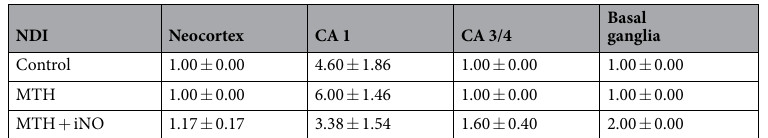
Table 2. Neuronal damage index. Conventional hematoxylin/eosin (H&E) and Mouse anti-Neuronal Nuclei (NeuN) staining was performed. A neuronal damage index (NDI) was semiquantitatively assessed for all regions of interest. The proportion of neuronal cells showing shrunken and/or hypereosinophilic cytoplasm (H&E staining) in combination with a significant decrease or loss of NeuN-immunoreactivity was determined and summarized in a score from 1(no/minimum damage) − 11 (maximum damage). Histopathological evaluation did not reveal any statistically significant differences between groups; mean ±